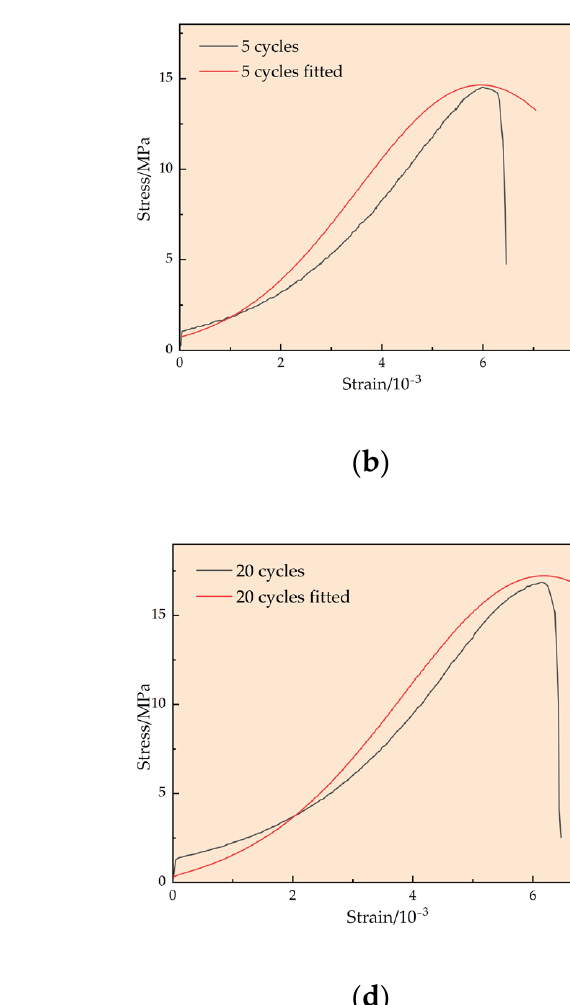
Figure 9. Strain–damage fitting curves of fracture-containing grouted rock specimens under dry and wet cycles.